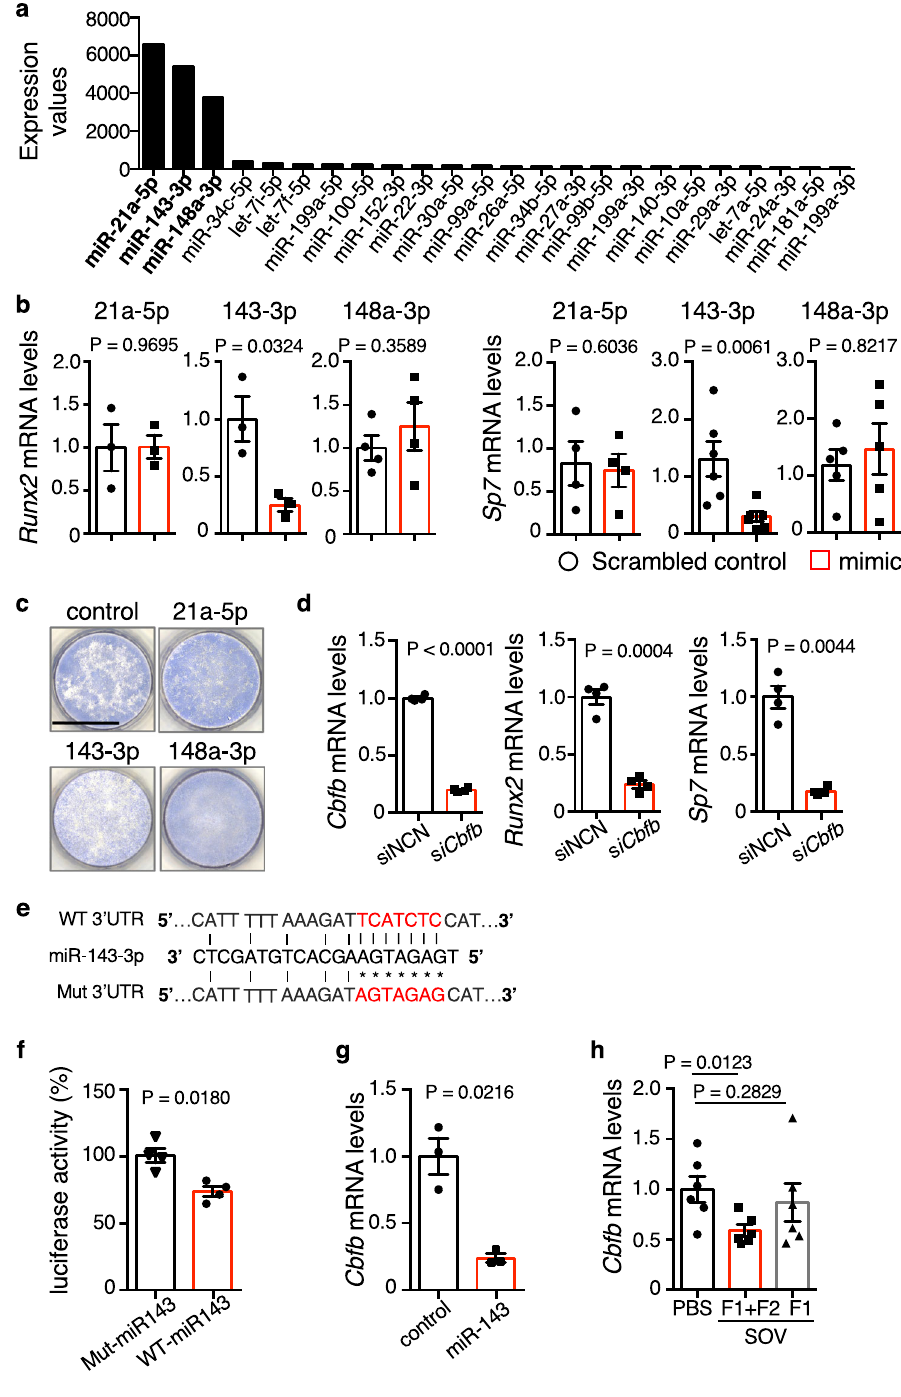
revealed that, compared with control mice, miR-143/145 Osx − / − mice had an increased bone volume/tissue volume (BV/TV) and bone mineral density (BMD) (Fig. 5a, b). Similarly, bone mor- phometric analyses showed that the parameters of bone forma- tion — including osteoid volume/bone volume (OV/BV), mineral apposition rate (MAR), and bone formation rate/tissue volume (BFR/TV) — were signi fi cantly increased in miR-143/145 Osx − / − mice, compared with littermate control mice (Fig. 5c, d). Although the osteoblast surface/bone surface (Ob.S/BS) was comparable between miR-143/145 Osx − / − and control mice (Supplementary Fig. S5c), the cuboidal Ob.S/Ob.S (ratio of Ob.S of mOBs to Ob.S of total osteoblasts) was signi fi cantly higher